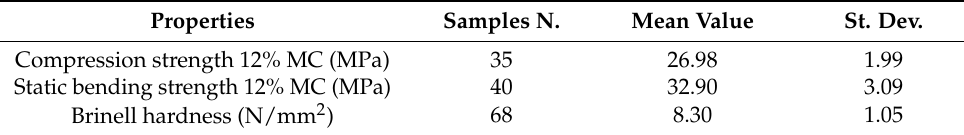
Table 5. Mechanical properties of heat-treated ayous